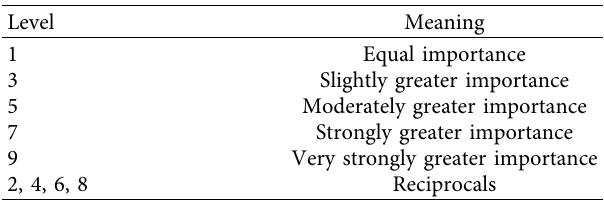
Figure 1: AHP hierarchy structure diagram. Table 1: Meaning of relative importance comparison